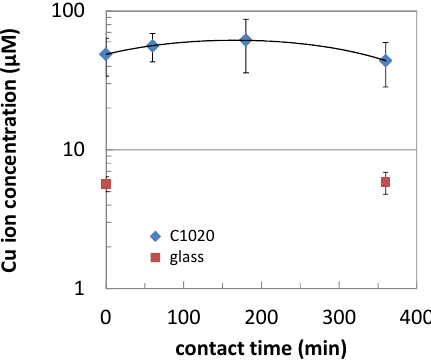
Figure 5. Copper ion release from C1020 under the same condition to nucleic acid degradation assay (mean ± standard deviation).